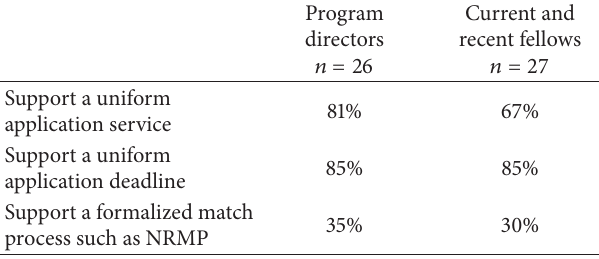
Table 2: Program director and fellow support of a uniform applica- tion system.